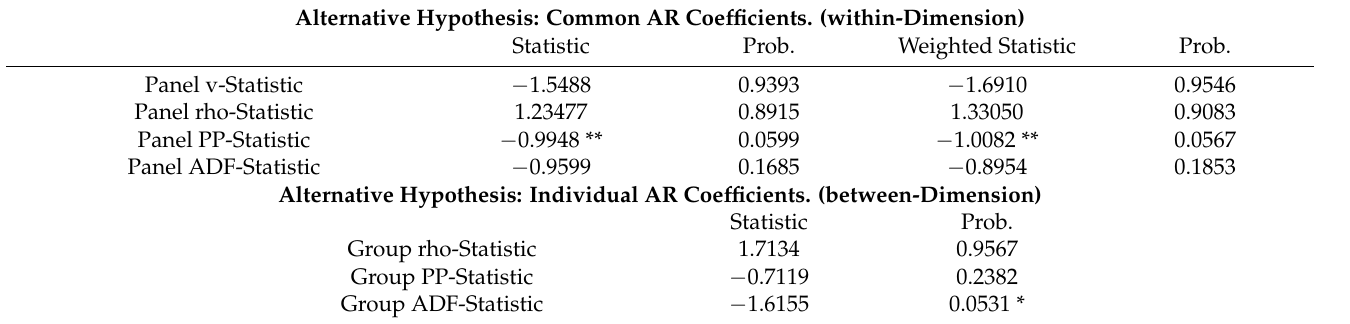
Table 5. Pedroni Co-integration Test.